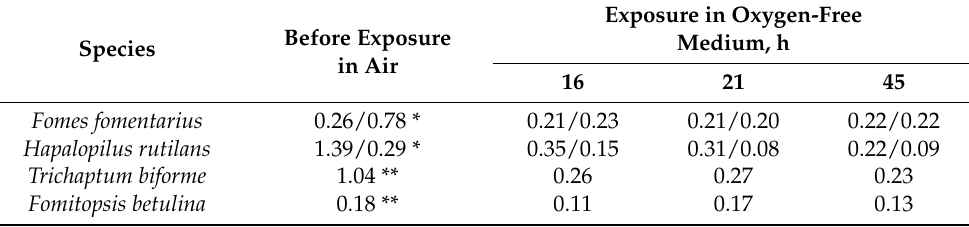
Table 7. Emission CO 2 (vol. %/h) by basidiocarps and substrates in the air and in oxygen-free nitrogen